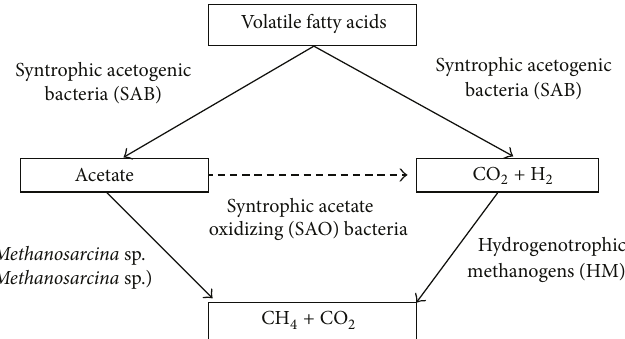
Figure 2: Methanogenesis in anaerobic digestion as documented for normal waste treatment reactor systems [42]. The SAB consist mostly of 𝐶𝑙𝑜𝑠𝑡𝑟𝑖𝑑𝑖𝑢𝑚 sp. at both mesophilic and thermophilic conditions [43]. The hydrogenotrophic methanogens in both mesophilic and thermophilic anaerobic digesters belong to the two orders of Methanobacteriales and Methanomicrobiales